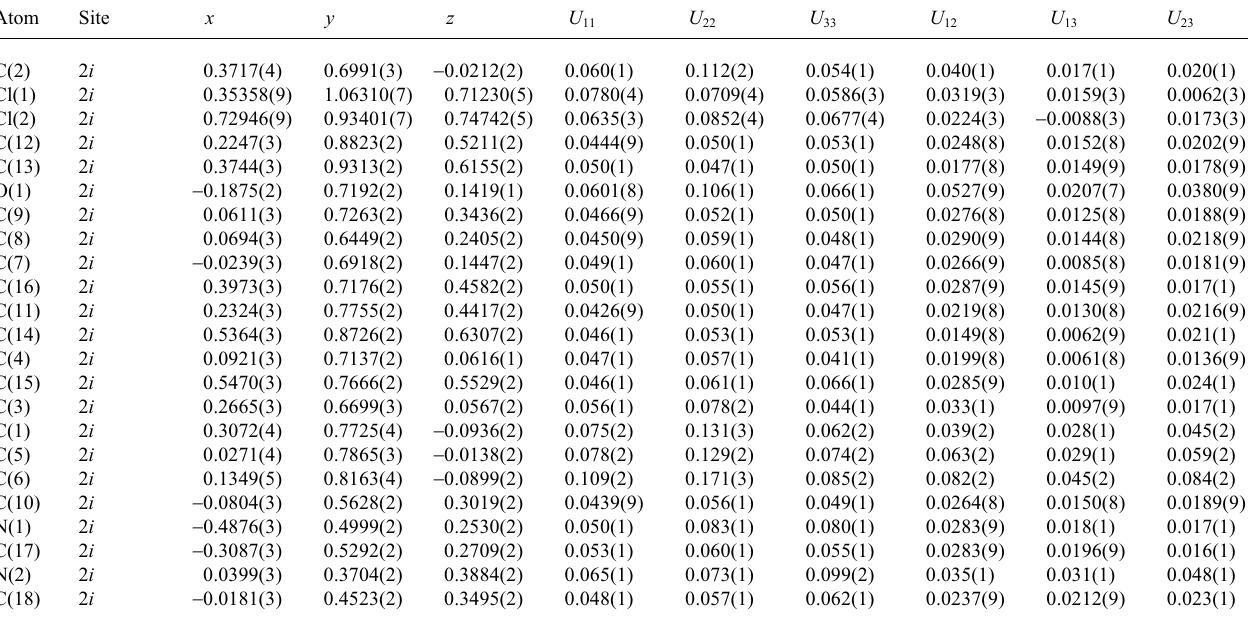
Table 3. Atomic coordinates and displacement parameters (in Å 2 )